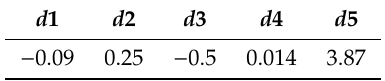
Table 2. Johnson–Cook failure parameter of TC4